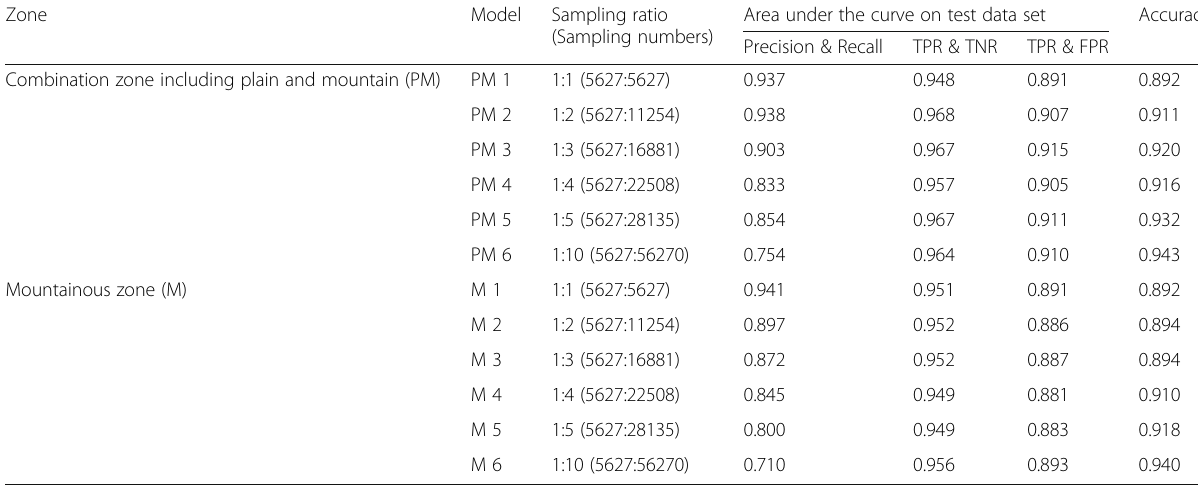
Table 1 The area under the curve and accuracy of models ’ responses in sampling ratios for the combination zone including plain and mountain (PM) and for the mountainous only zone (M) Zone Model Sampling ratio Area under the curve on test data (Sampling numbers)